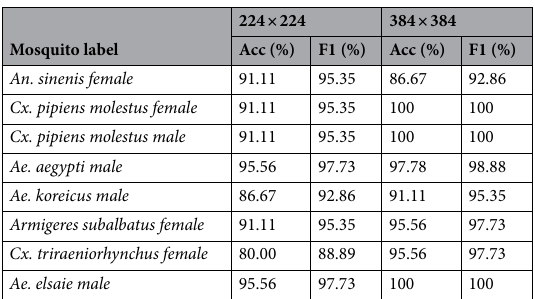
Table 2. Comparison of recognition accuracy for different input image sizes. Mosquito species with same recognition accuracy between 2 input image sizes were not listed in the table. Acc was short for accuracy and F1 was shoret for